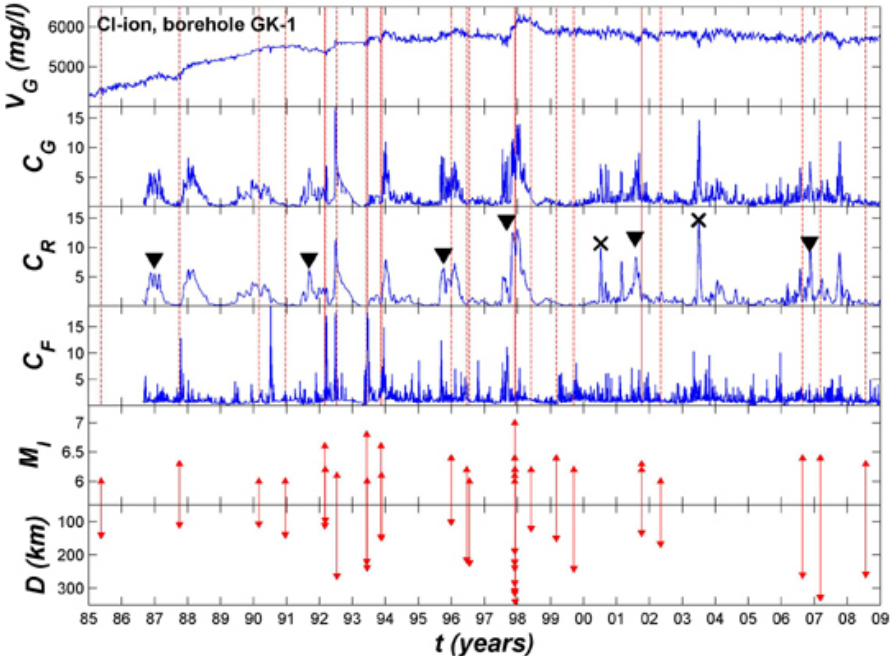
Fig. 2. Comparison of nonstationarity factor C J ( T = 600days, 1T = 3days) for the GK-1 chlorine-ion concentration time series with seismic activity: V G – source signal; C G – nonstationarity factor for V G , C R – nonstationarity factor for the low-frequency component of V G , C F – nonstationarity factor for the high-frequency component of V G , M l – local earthquake magnitude, D – distance from the epicenter. Solid triangles denote sample C R spikes preceding large earthquakes. Crosses denote sample C R spikes not related to large seismic events.